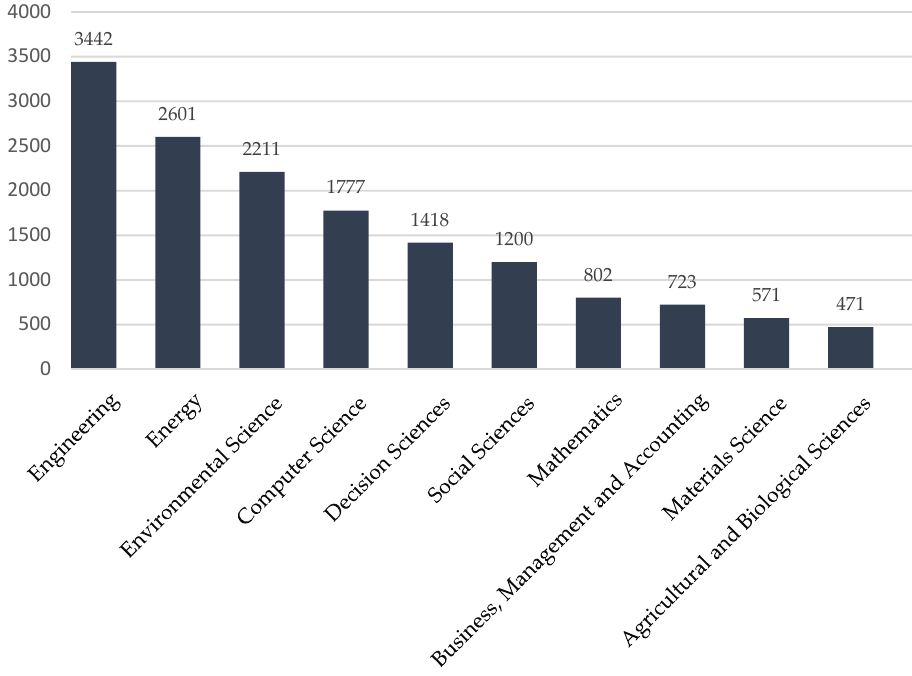
Figure 4. Studies on MCDM—Number of Articles from 2012 to 2021.